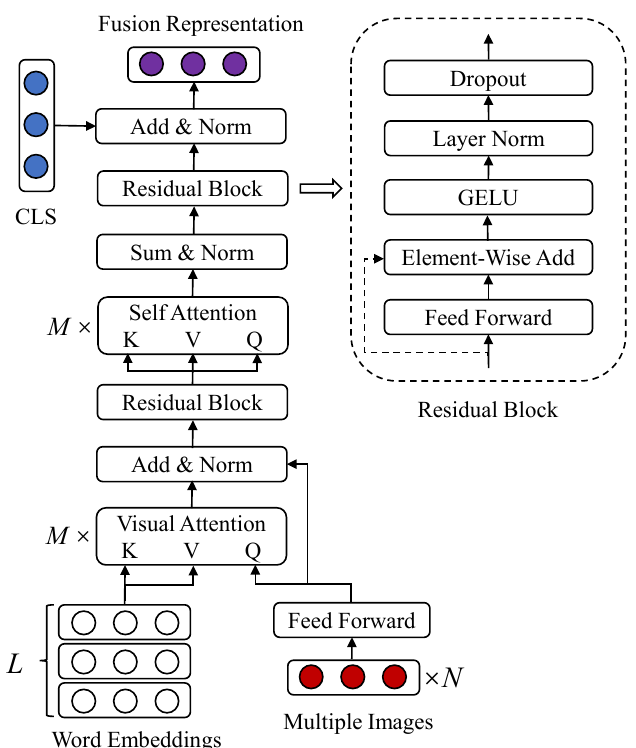
Figure 4. The visual features of N images are utilized as queries, while L word representations are employed as keys and values in multi-head visual